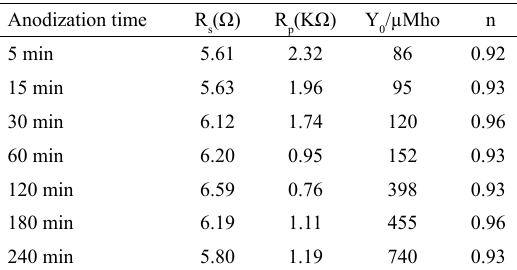
nanotubes obtained at different anodization times, where the symbols represent the experimental data Figure 9. (a) Nyquist plots of TiO 2 and Y obtained from the circuit fitting as a function of anodization time. and the solid lines represent circuit fitting; and (b) values of R p 0 Table 1. EIS parameters for the